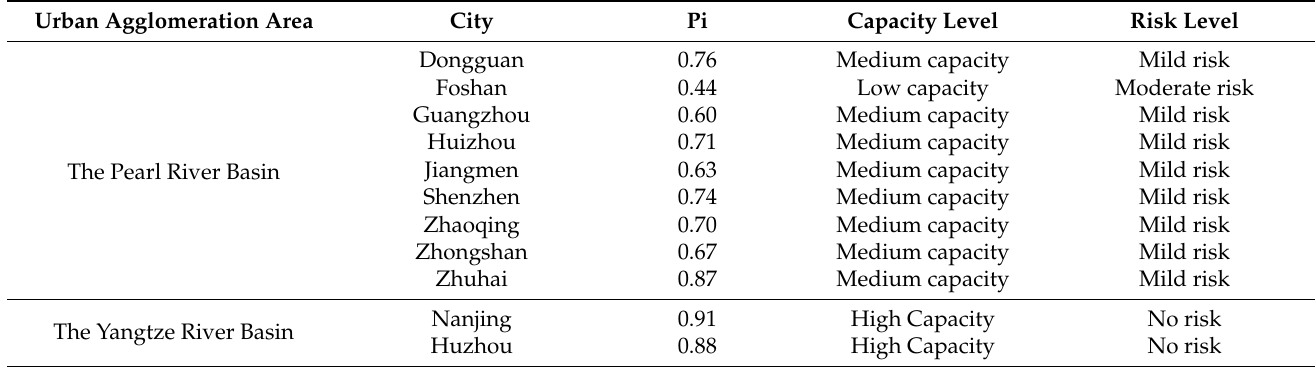
Table 5. The soil environmental capacity level of agricultural land in urban agglomeration area. Urban Agglomeration Area City